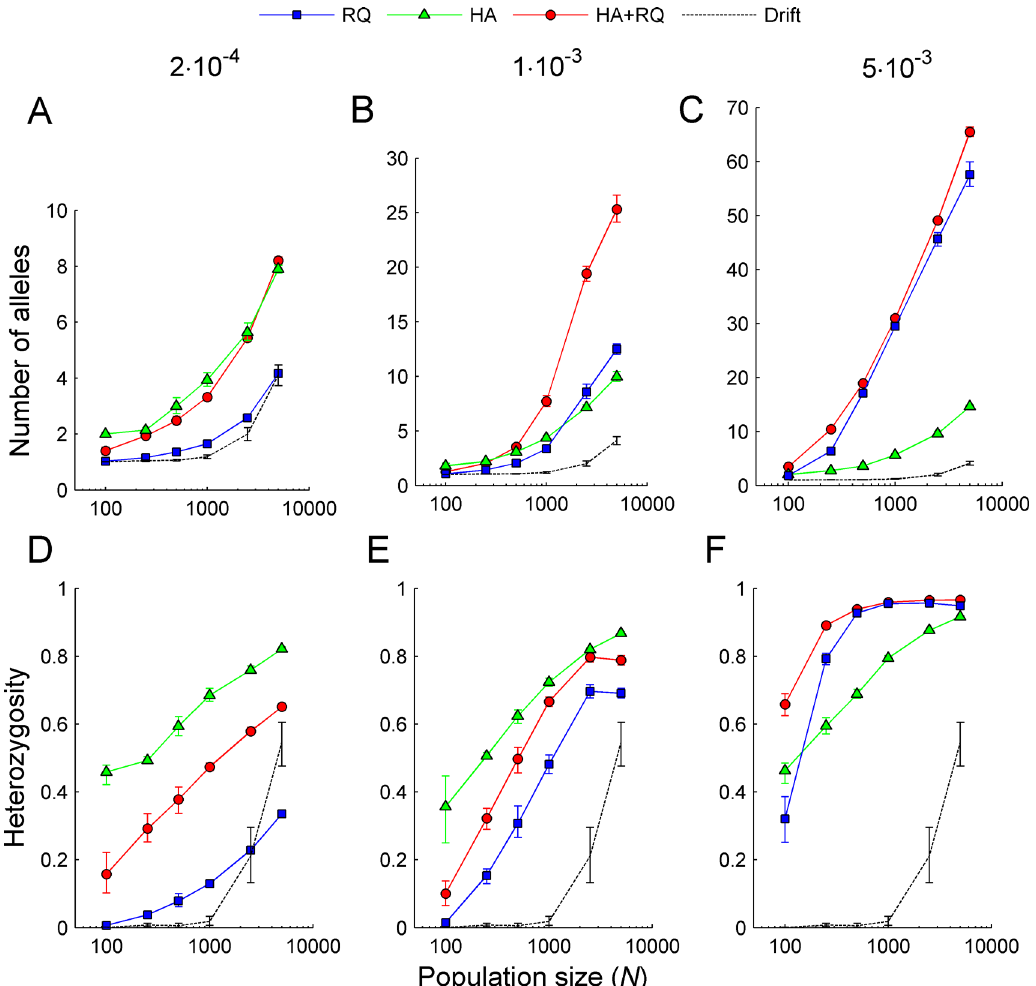
Fig 2. Population size and MHC polymorphism. Impact of population size on the maintenance of MHC polymorphism (upper panels) and heterozygosity (lower panels) under three simulated scenarios – heterozygote advantage (HA), Red Queen (RQ) dynamics, and both (HA+RQ) (see legend) – with three pathogen mutation rates (given above the panels). Data points indicate the mean number of MHC alleles (A-C) and mean heterozygosity (D-F) and are calculated across the last 6000 generations of 10 replicate simulations. Error bars indicate bootstrapped 95% confidence intervals.